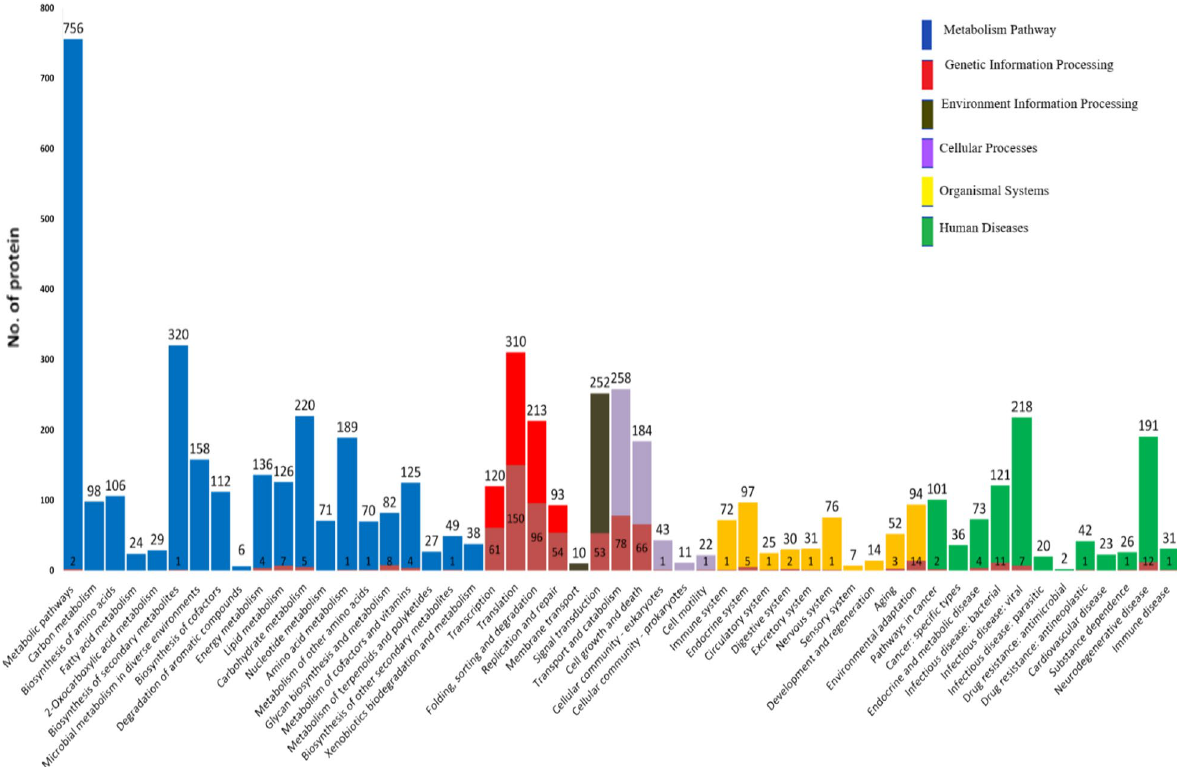
Fig. 1 Tabulation of M. guilliermondii strain SO proteins into 53 interconnected KEGG pathway. The stacked on the column base indicates solely hits of annotation to the respected pathway maps